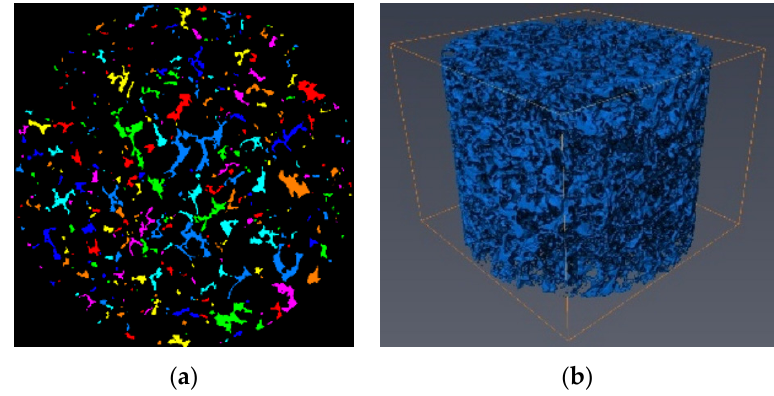
Figure 2. ( a ) Air void phase in a typical slice. ( b ) Volume rendering reconstruction.